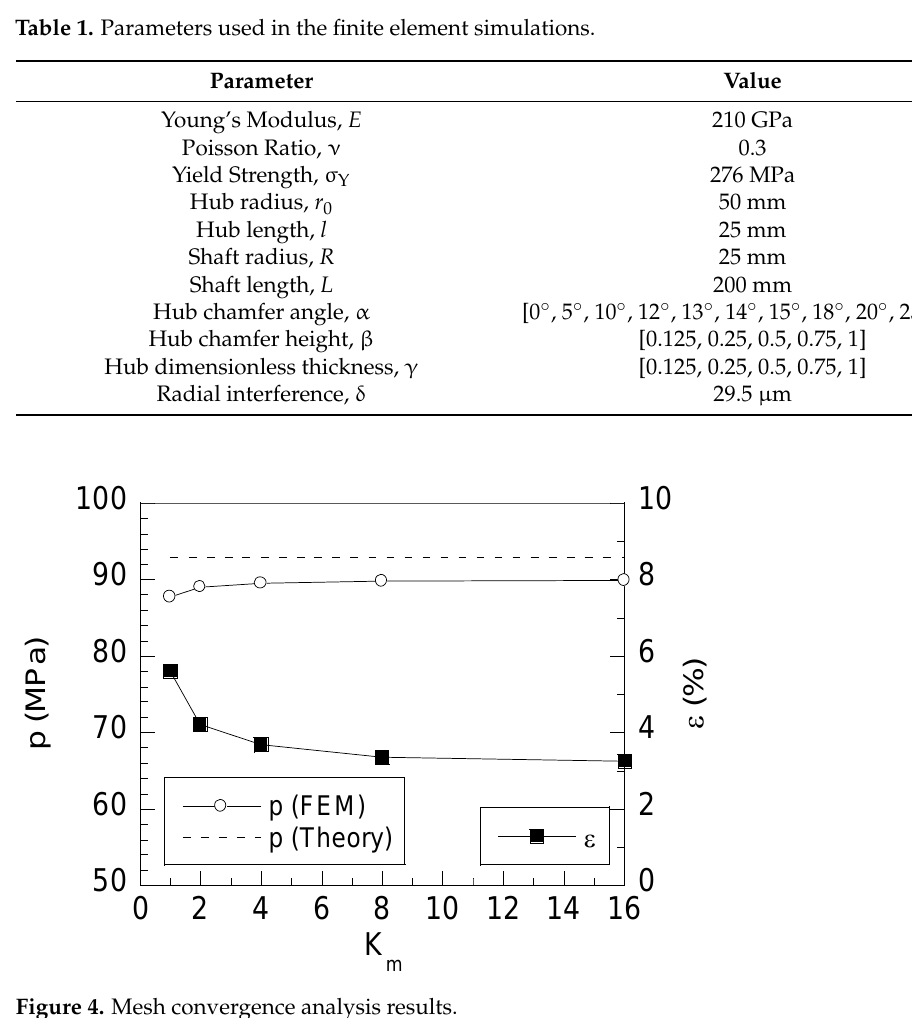
Table 1. Parameters used in the finite element simulations.